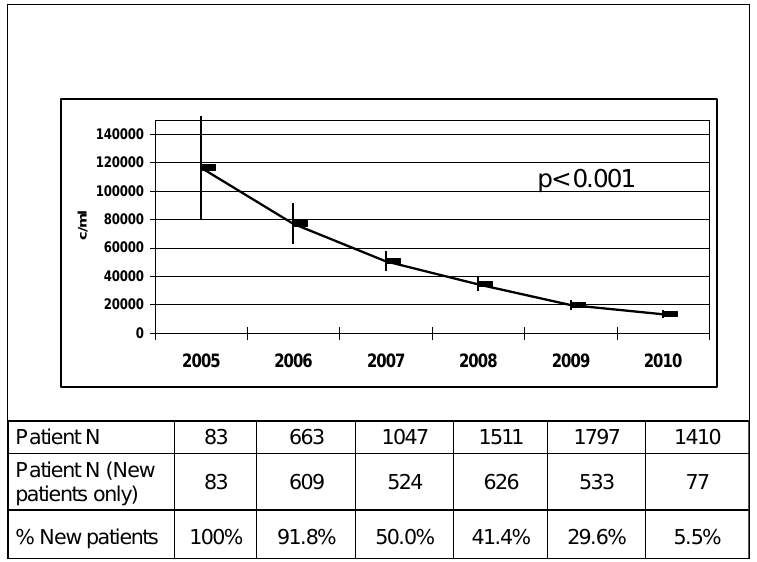
Figure 4. Mean virus load (and 95% CL) of DREAM program pregnant patients at one of our centers over time. CL: Confidence